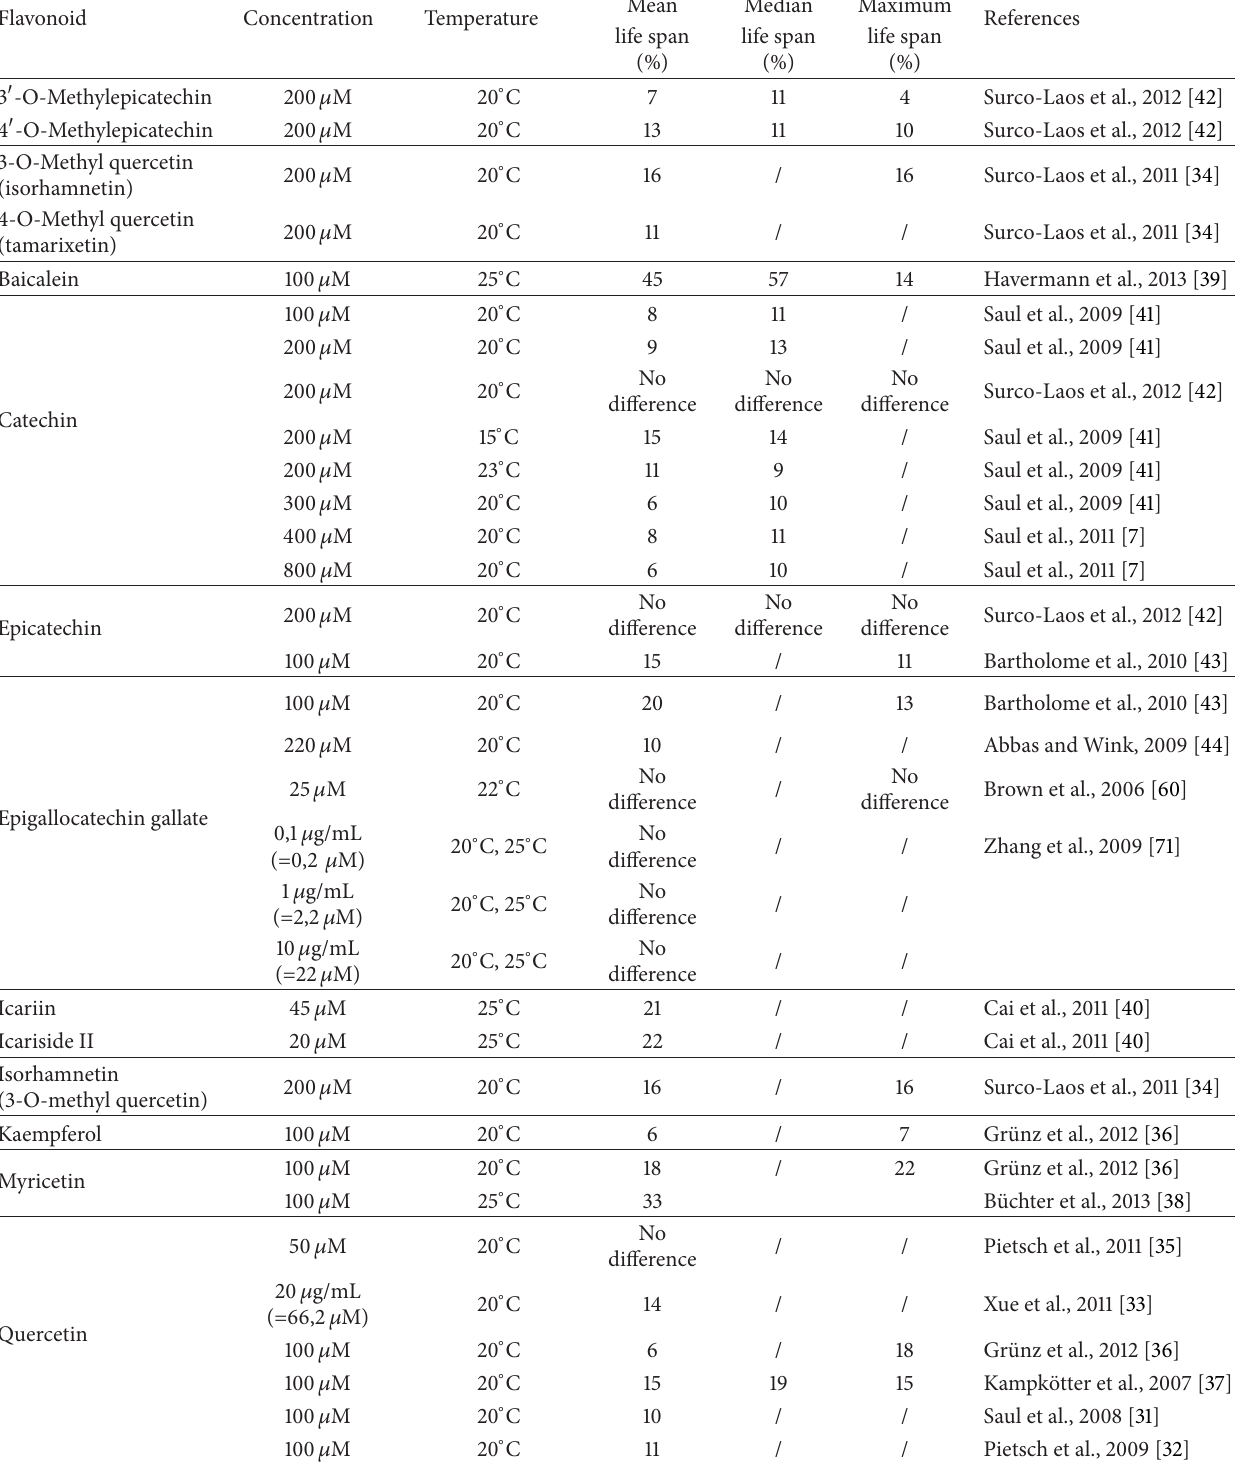
Table 1: Modulation of the mean, median, and maximum life span in C. elegans by flavonoids in different studies. Flavonoid